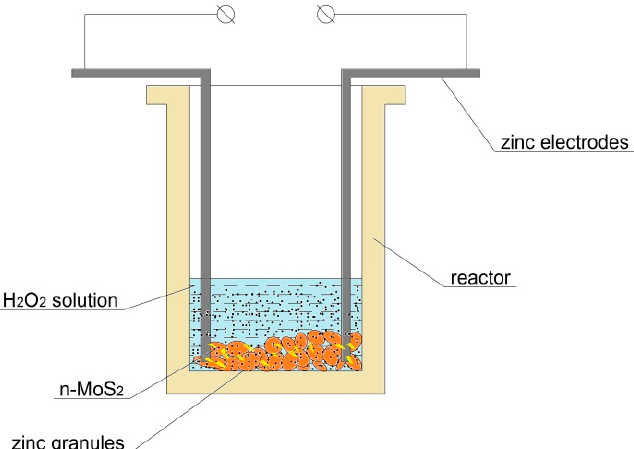
Figure 1. Scheme of the electrospark erosion experiment for the fabrication of MoS 2 @ZnO nanoheterostructures.